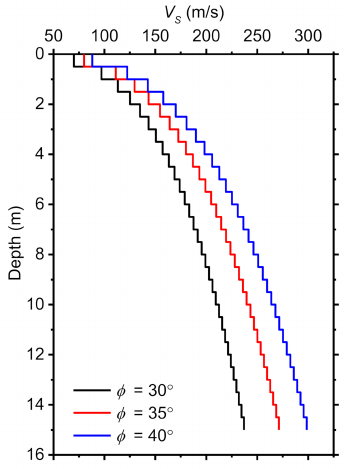
Figure 3. V s vs. depth profiles used in the FE model.